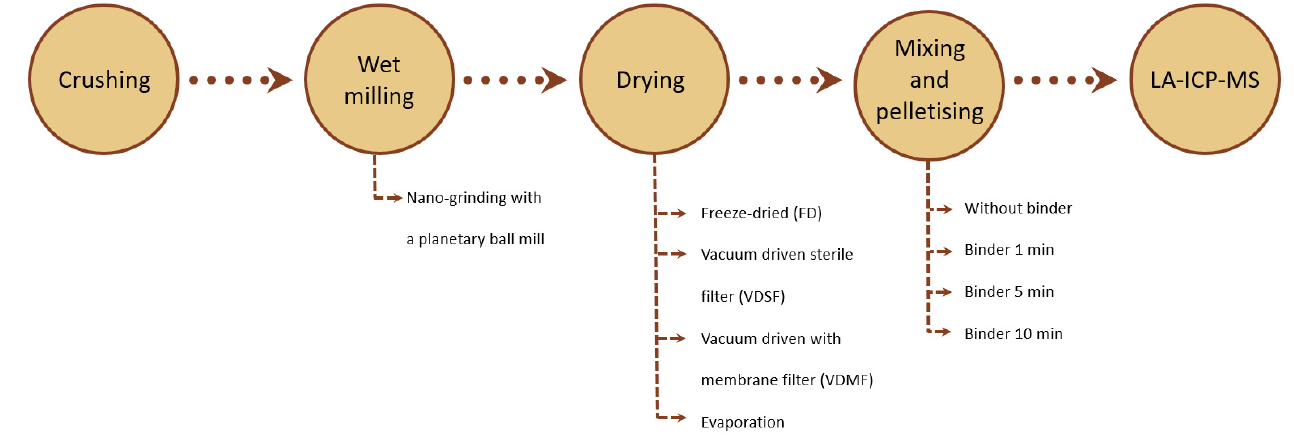
Figure 1. Flowchart of the pellet production and analysis process from whole-rock to analysis.